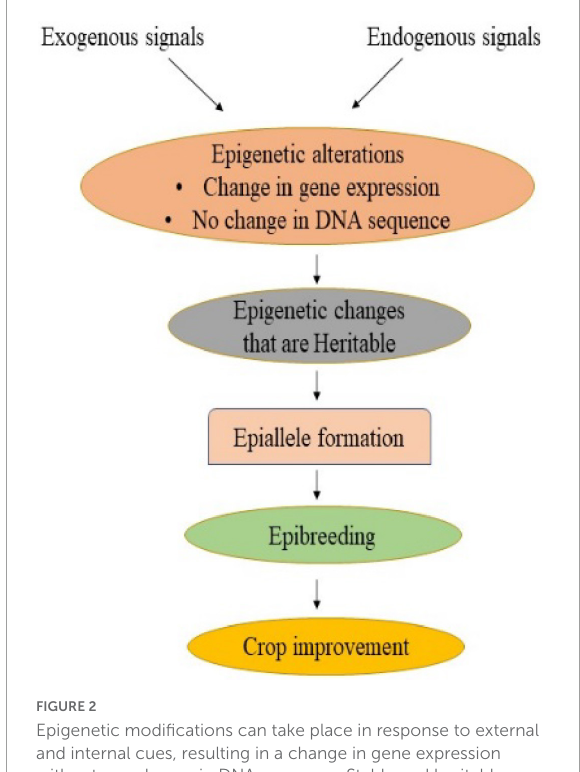
FIGURE2 Epigenetic modifications can take place in response to external and internal cues, resulting in a change in gene expression without any change in DNA sequence. Stable and heritable epigenetic changes lead to the formation of epialleles which can be used in epibreeding programmes for crop